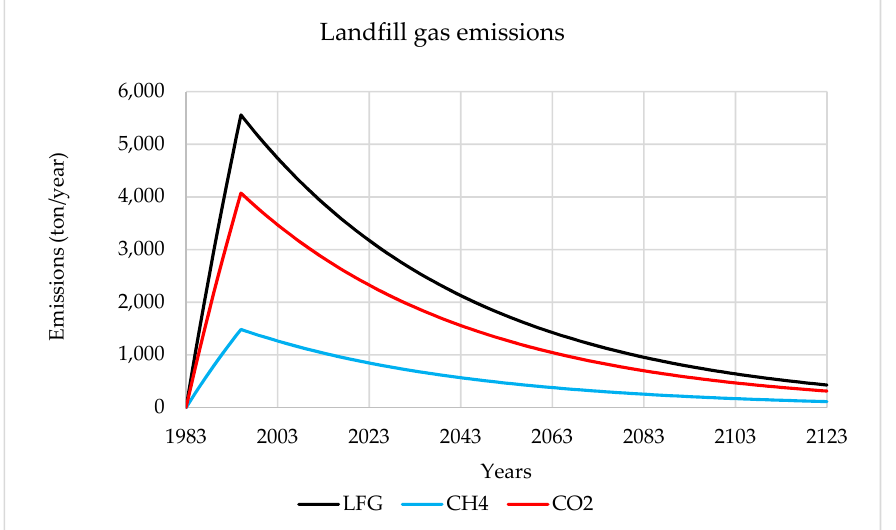
Table 2. Life cycle inventory of MSW landfilling.